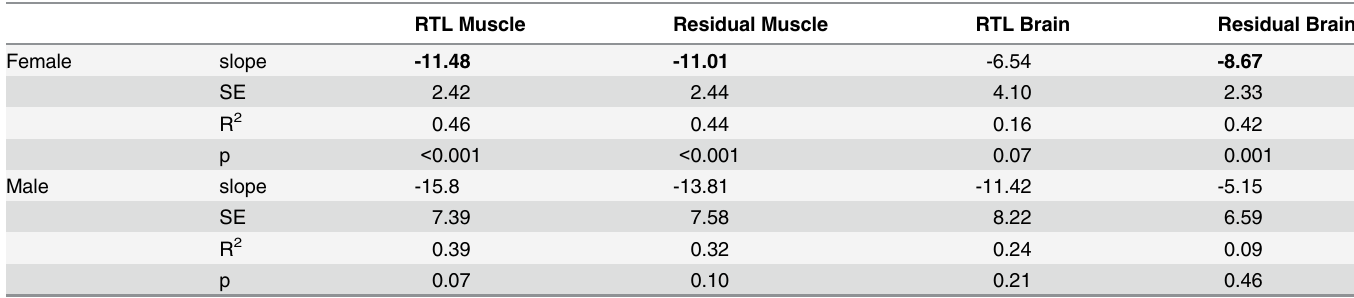
The signi fi cant values are in bold and SE stands for standard error. The signi fi cance test for p < 0.001 means that p is within the interval [0,